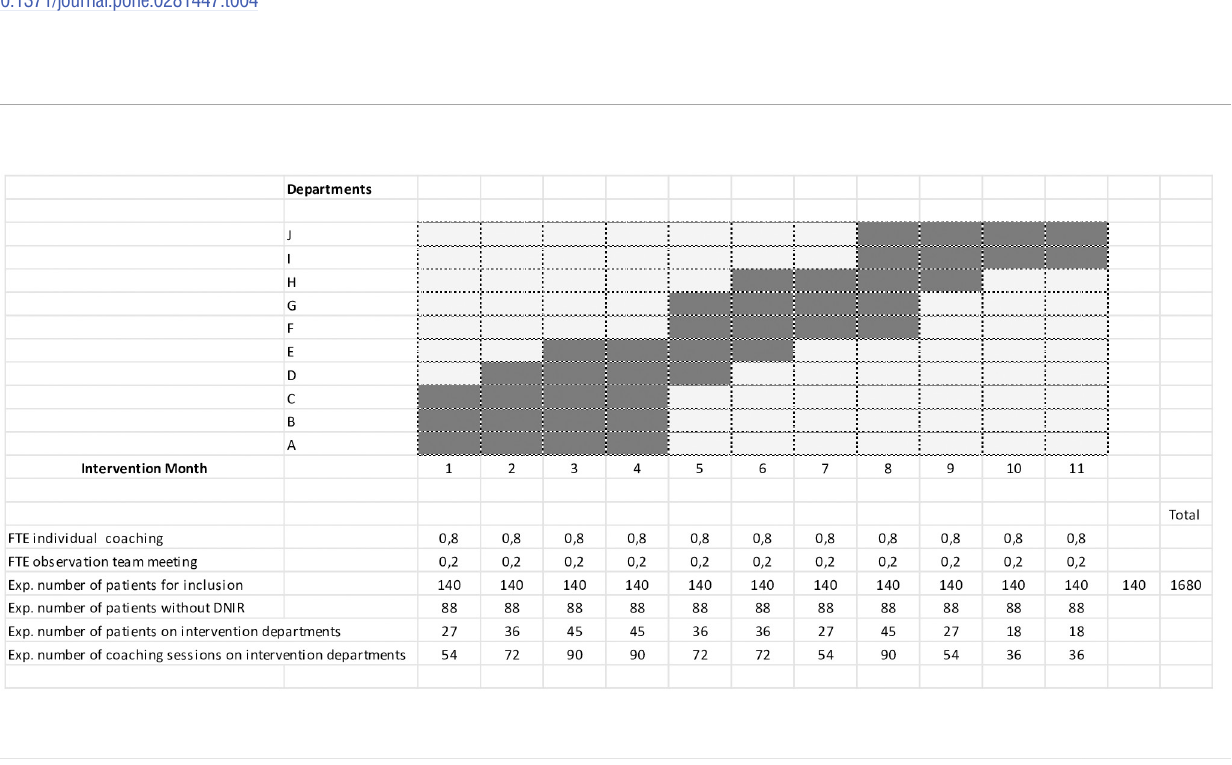
Fig 3. Trial design (stepped wedge cluster randomized controlled trial). Based on the results of a pilot study (Table 1), we expect that 4 patients per ward per week will be identified by clinicians as potentially receiving excessive care; expanded to 1 month and 10 wards this yields to 160 patients. Taking to account that one in eight patients might be re-admissions and/or patients with length of stay of more than one week, we drop this total amount to 140, of whom 88 without a DNIR code over 10 departments. This yields to 9 patients and 18 coaching sessions (one junior and one senior doctor per patient) per month per department. As 2 to 5 departments will have the intervention at the same time, the expected number of coaching sessions varies between 36 and 90 sessions per month. The black bars indicate the intervention period across all 10 departments. All 10 departments were randomly assigned to start a 4-month coaching period in month k = 1, ... ,10 following a stratified design. In particular, the 3 departments with the highest incidence of written DNIR orders (based on historical data, Table 1) were randomly assigned to start the intervention in months 2, 4 and 6 (each time together with another ward). The 7 other wards were randomly assigned to start the intervention. Subsequently, departments in which senior doctors remain in charge of their own hospitalized patients (in contrast to departments in which one senior doctor is in charge of all hospitalized patients on a specific ward) were spread in order to reduce the workload of the coach. One month was added to compensate for the absence of the coach for whatever